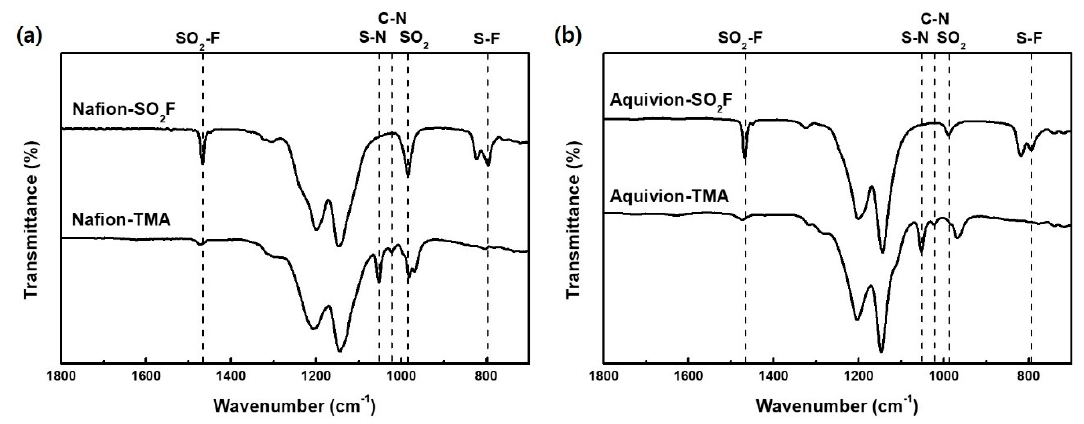
Figure 1. FT-IR spectra of the ( a ) Nafion- and ( b ) Aquivion-based polymers before and after quaternization.